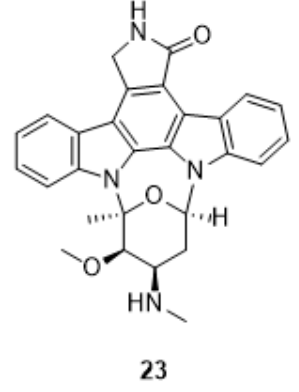
Figure 9. Structure of staurosporine ( 23 ).